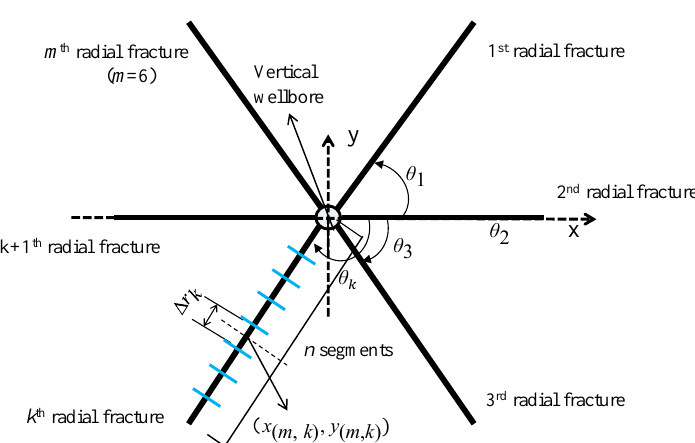
Figure 4. Schematic of a vertical well with multiple radial fractures.